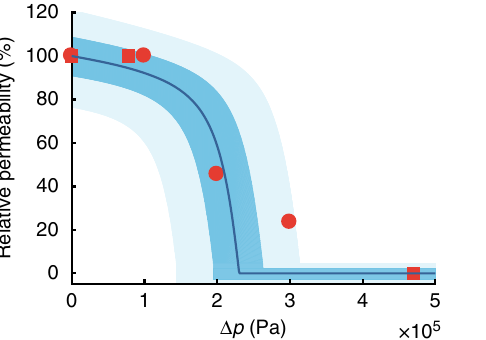
Fig. 4 Impact of pressure on PD permeability. Relative permeability P ( P 0 ) − 1 is plotted as a function of applied pressure Δ p (solid line). The two shaded regions indicated the sensitivity to the cytoplasmic sleeve width w = a o − a i (±10%, and ±25%). The PD ’ s ability to mediate transfer of solutes decline in sync with increasing pressure. Experimental data (dots and squares, from ref. 8 and ref. 9 , respectively) compare favorably with the model.